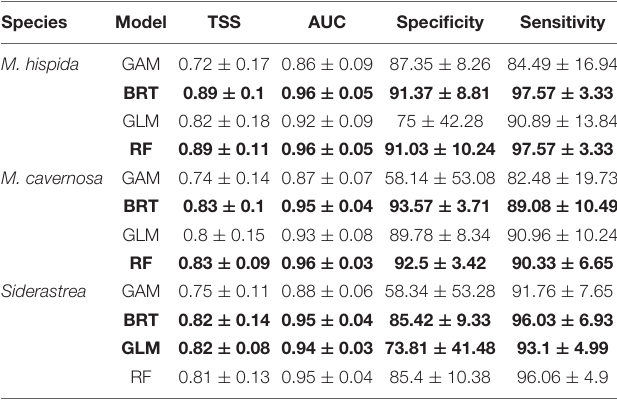
TABLE 1 | Performance of species distribution models for Mussismilia hispida , Montastraea cavernosa and Siderastrea obtained through four distinct algorithms. Species